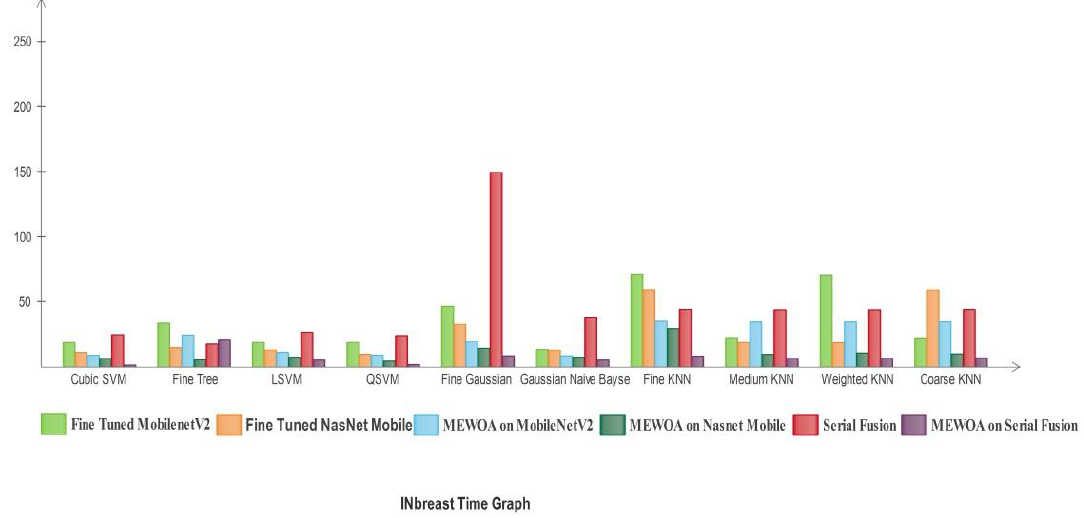
Figure 27. Time compared with individual machine learning classifiers of deep learning models for INbreast.